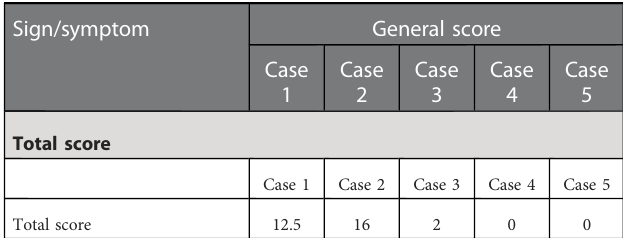
TABLE 2 FOS-MSSI (fabry outcome survey — mainz severity score